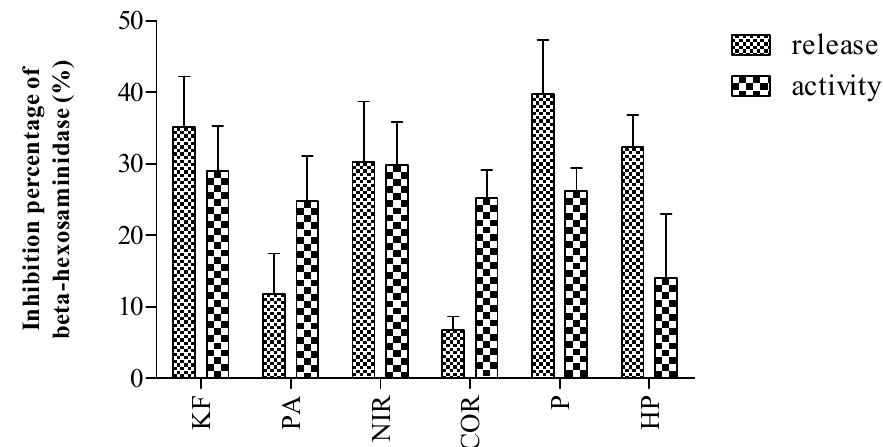
Figure 6. Inhibitory activity of P. amarus extract and its compounds towards the beta-hexosaminidase activity. Ketotifen fumarate (KF), P. amarus (PA), niranthin (NIR), corilagin (COR), phyllanthin (P), hypophyllanthin (HP).